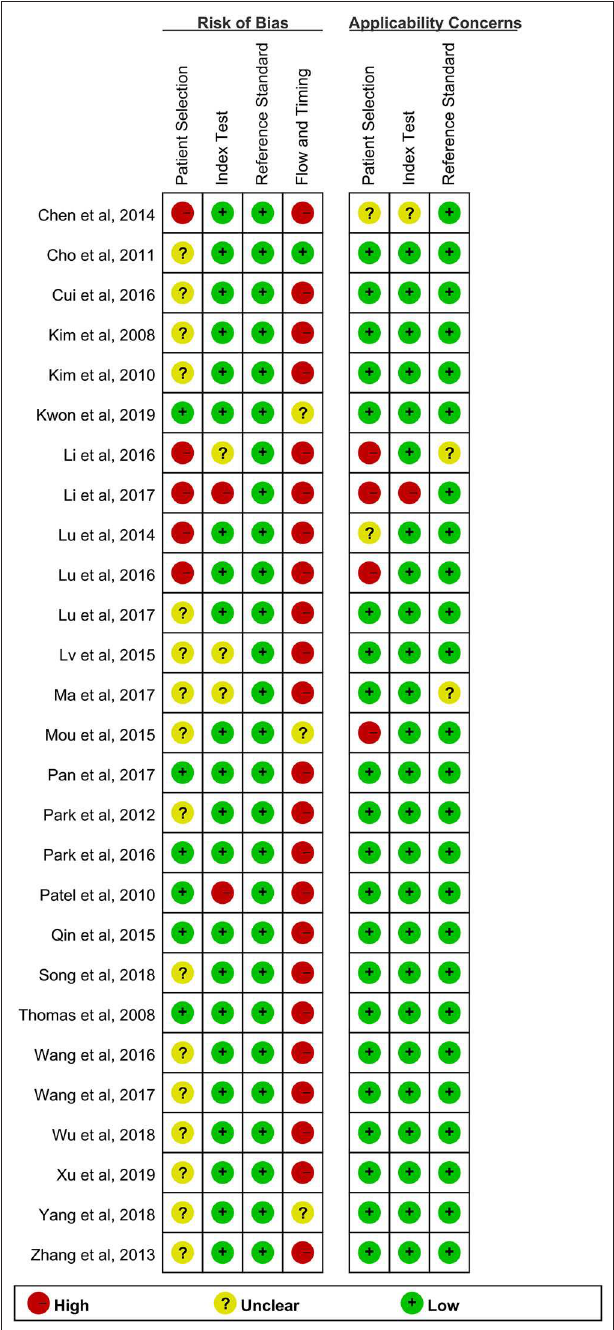
FIGURE 2 | Quality evaluation of articles